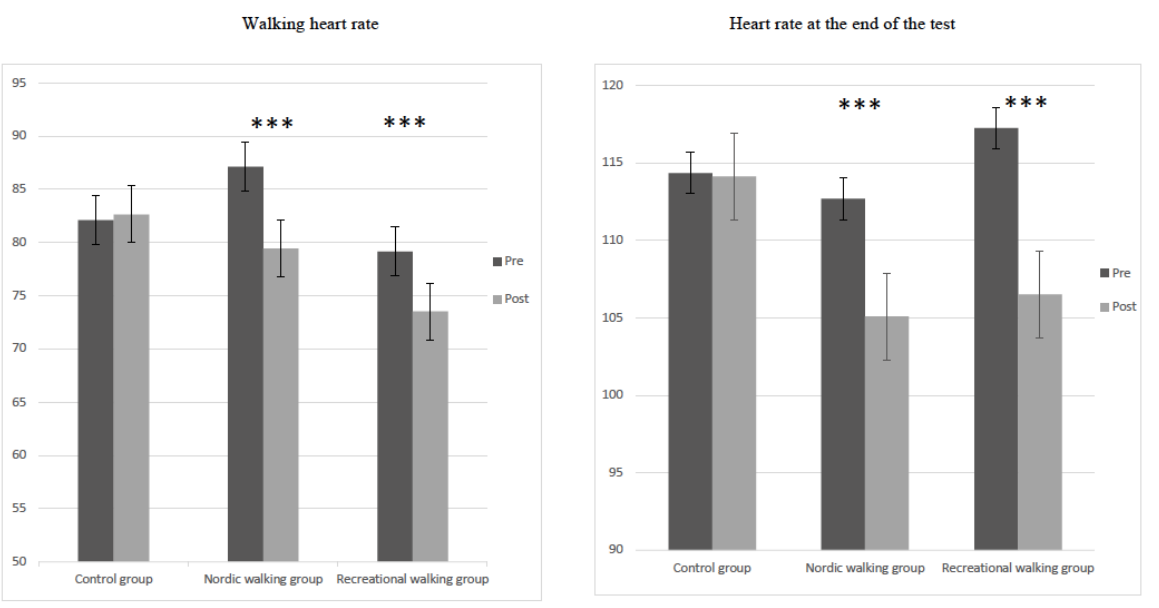
Figure 3. Differences in walking heart rate and heart rate at the end of the test in pretest and posttest interventions in the three studied groups. *** p < 0.001.